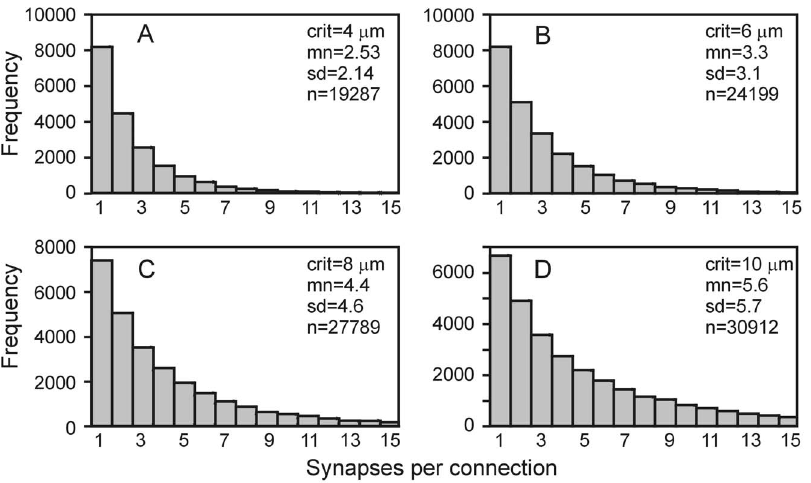
Figure 6. Frequency distributions of number of synapses per connection (connection strength) for different threshold distances for the formation of synapses. A, 4 m m. B, 6 m m. C, 8 m m. D, 10 m m.